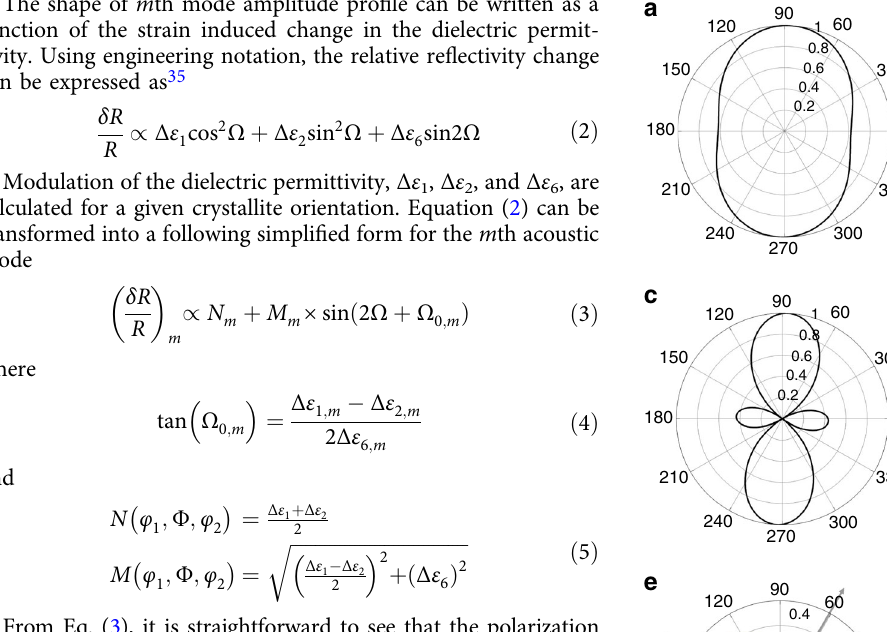
Fig. 4e, where two pro fi les that have the same values of φ 1 and Φ but different values for φ 2 (solid and dashed line) are compared.